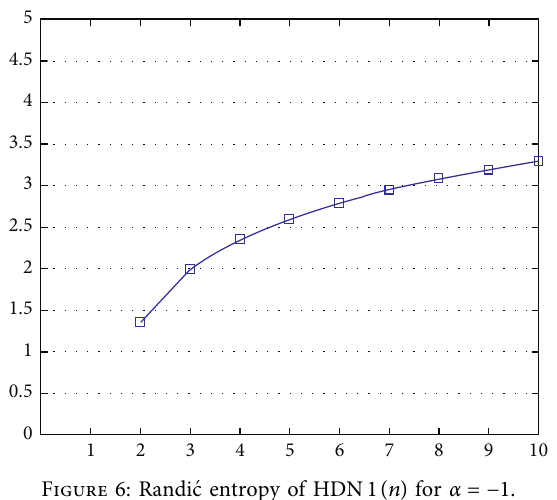
Figure 6: Randi´c entropy of HDN 1 ( n ) for α � − 1.